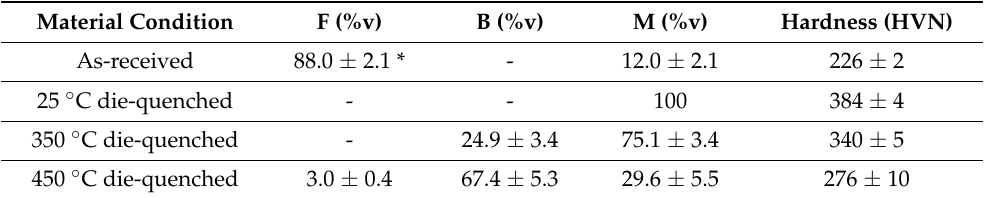
Table 2. The measured hardness and micro-constituent volume fractions (%v) for the studied microstructures of Ductibor ®